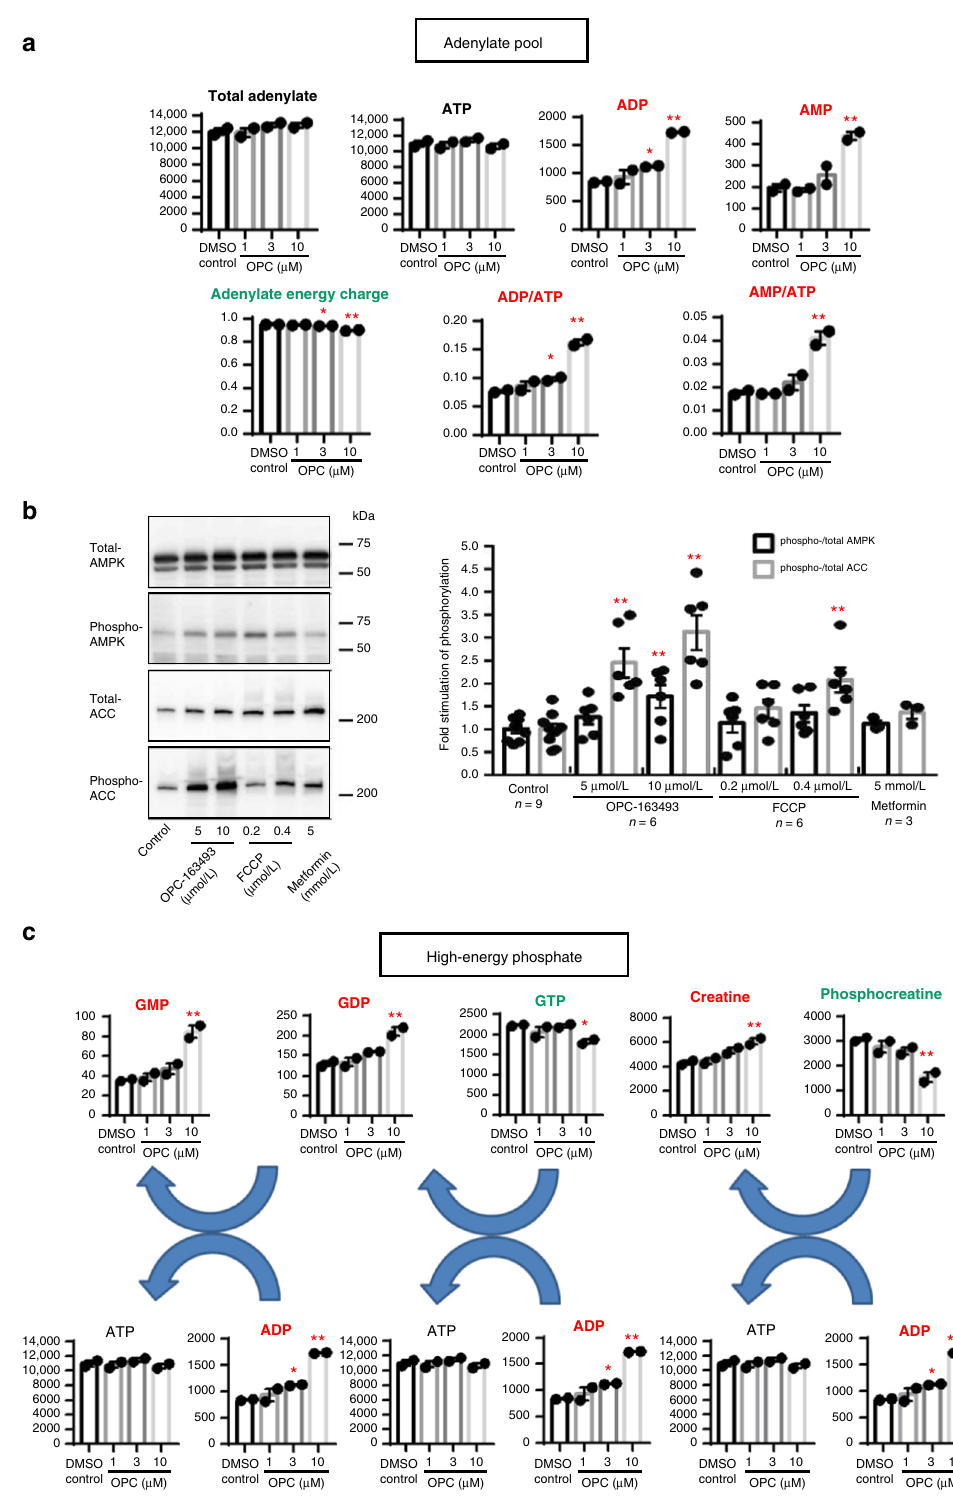
Fig. 4 Metabolomic analysis of in vitro effects of OPC-163493 in HepG2 cells. Data represent mean ± SE, n = 2 for metabolomic analysis ( a and c ), ∗ P < 0.05, ∗∗ P < 0.01, OPC vs. DMSO control using a two-tailed Williams ’ test. All units for vertical lines in metabolite graphs are pmol 10 6 cells − 1 (except ratios of substrates). When signi fi cant increases and decreases were observed, those graph titles were labeled with red and green, respectively. a Effects on adenylate pool. Total adenylate = [ATP] + [ADP] + [AMP], Adenylate energy charge = ([ATP] + 0.5 × [ADP])/[Total adenylate]. b Phosphorylation of AMPK and ACC in OPC-163493-treated HepG2 cells. Representative data are shown in western blots. Data represent mean ± SE. The numbers in each sample are described in the graph. ∗ P < 0.05, ∗∗ P < 0.01, OPC vs. DMSO control using a two-tailed Williams ’ test. Black bar, pAMPK/total AMPK; gray bar, pACC/total ACC. c Effects on high-energy